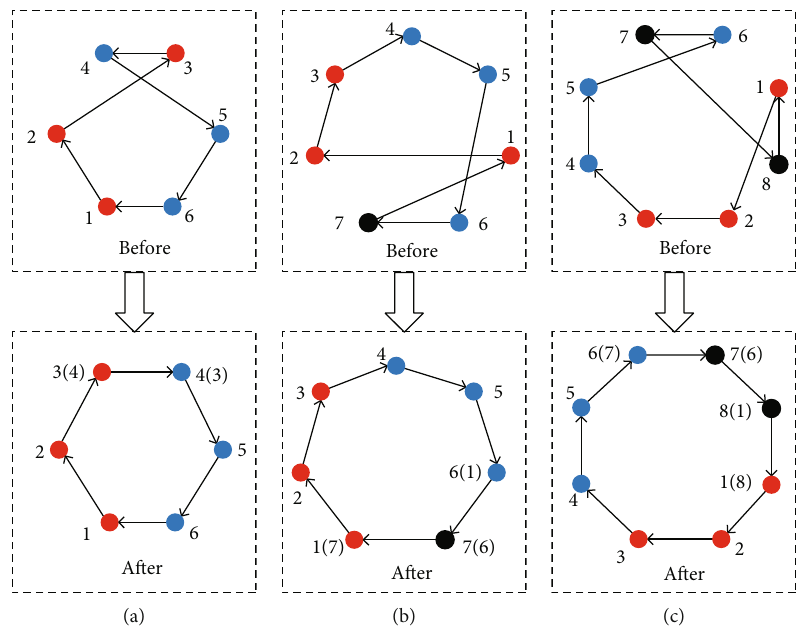
Figure 5: An example of the process of the adaptive local adjustment operator: (a) n = 6 and h = 3 ; (b) n = 7 and h = 3 ; (c) n = 8 and h = 3